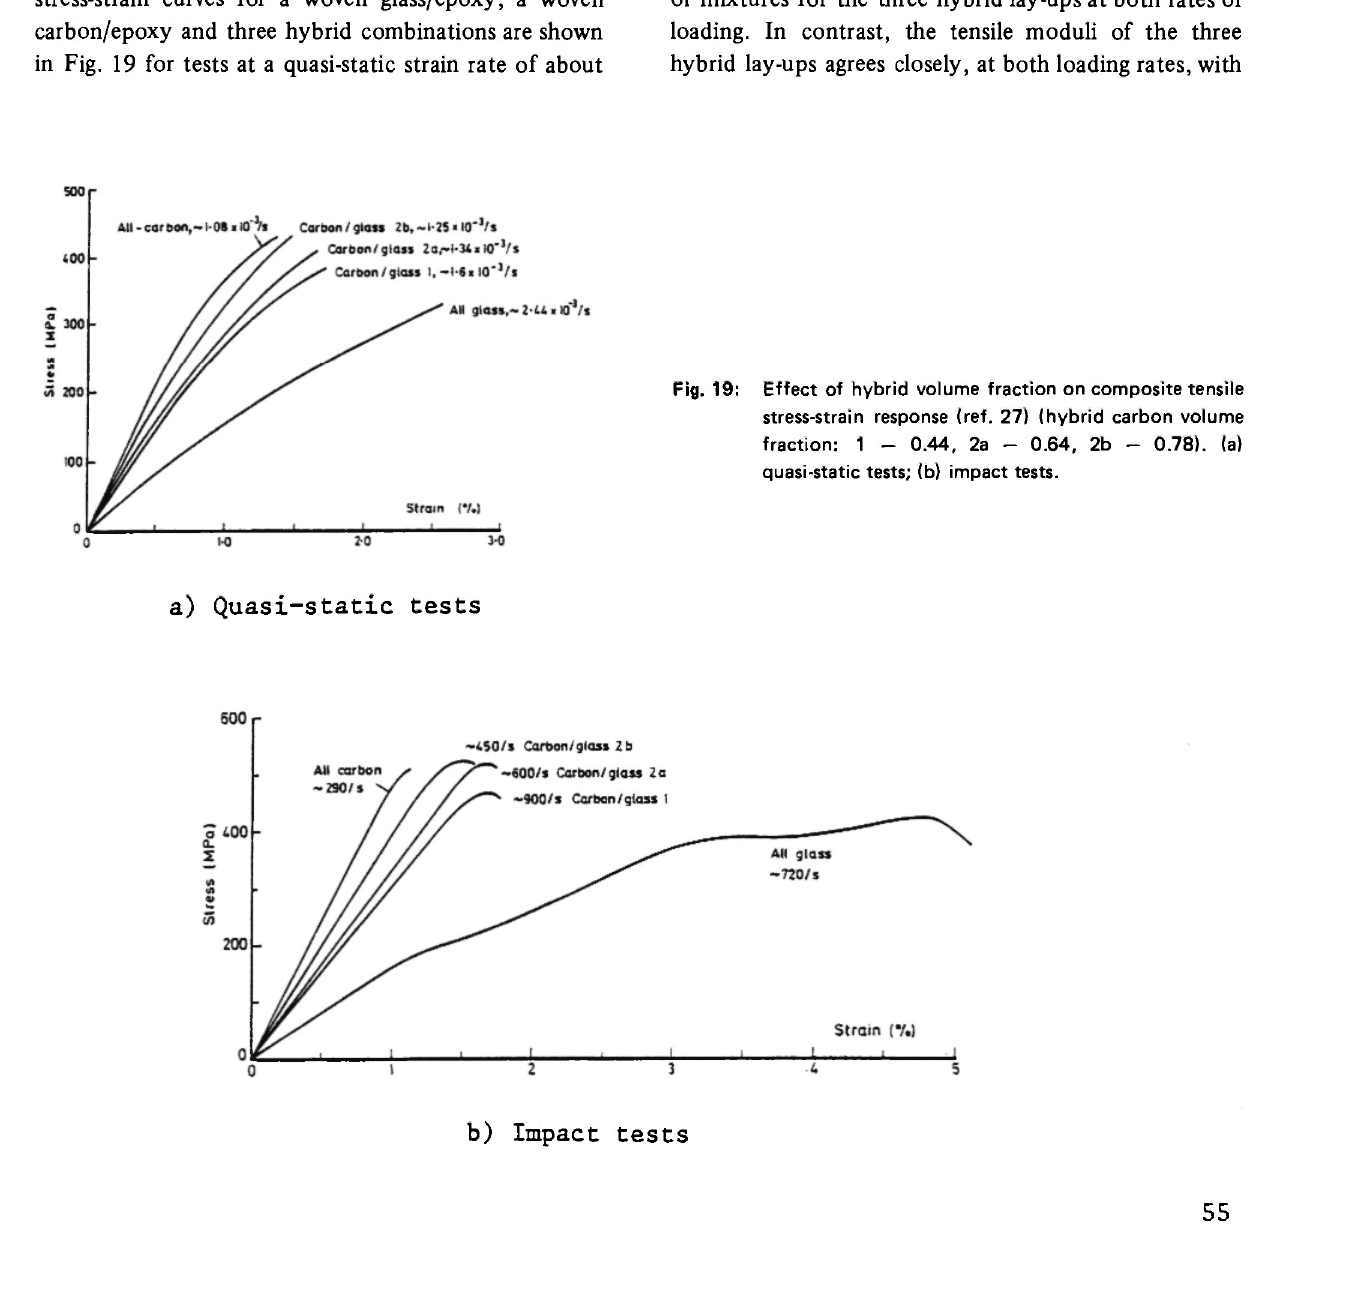
Fig. 19: Effect of hybrid volume fraction on composite tensile stress-strain response (ref. 27) (hybrid carbon volume fraction: 1 - 0.44, 2a - 0.64, 2b - 0.78). (a) quasi-static tests; (b) impact